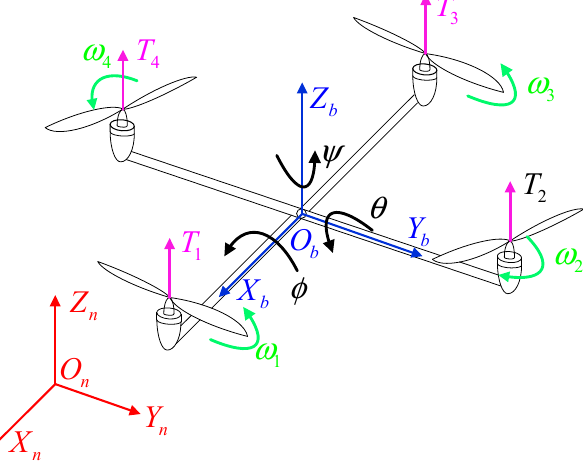
Figure 5. The coordinate systems of a multicopter.